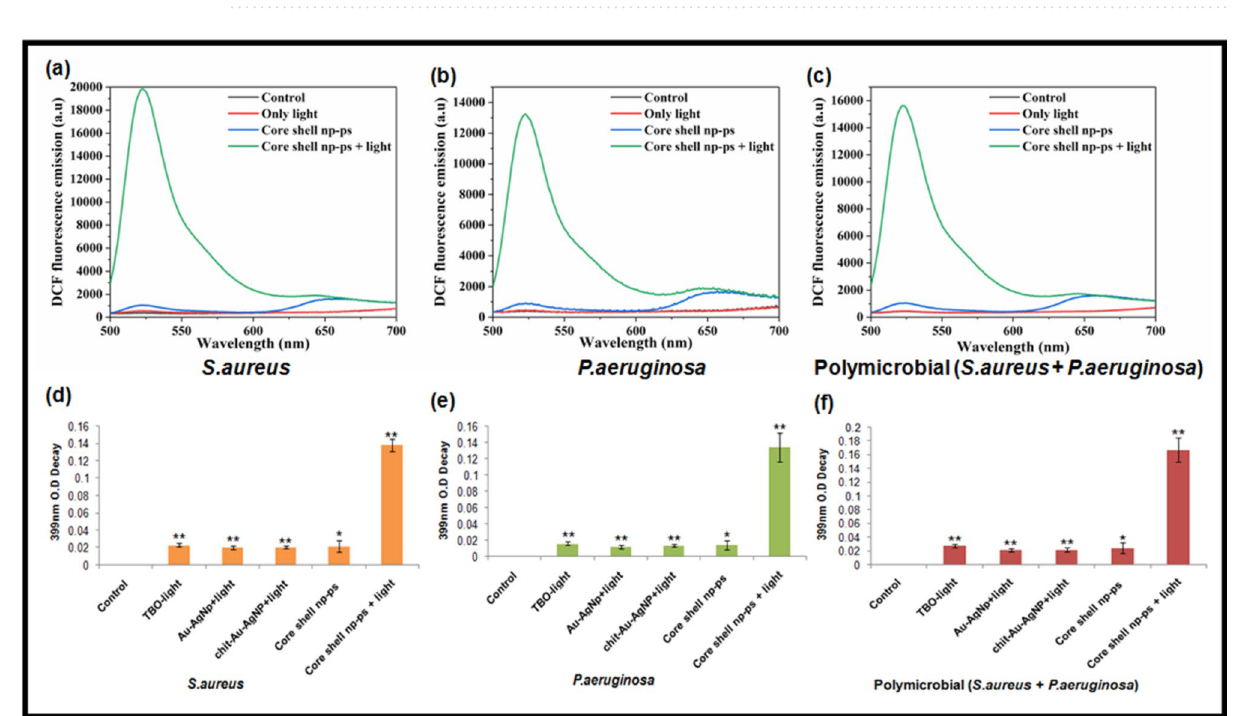
Figure 5. Detection of total reactive oxygen species ( a )–( c ) and quantification of singlet oxygen ( d )–( f ) in monomicrobial S. aureus , monomicrobial P. aeruginosa and polymicrobial S. aureus + P. aeruginosa biofilms in control group, TBO–chit–Au–AgNPs treated group and TBO–chit–Au–AgNPs + laser treated group. 630 nm laser (100 J/cm 2 , 12 min and 50 s) were used in the corresponding laser group. The data represents an average of triplicate experiments ± SD ( p -value * p < 0.01, ** p < 0.001, *** p < 0.0001, ns = not